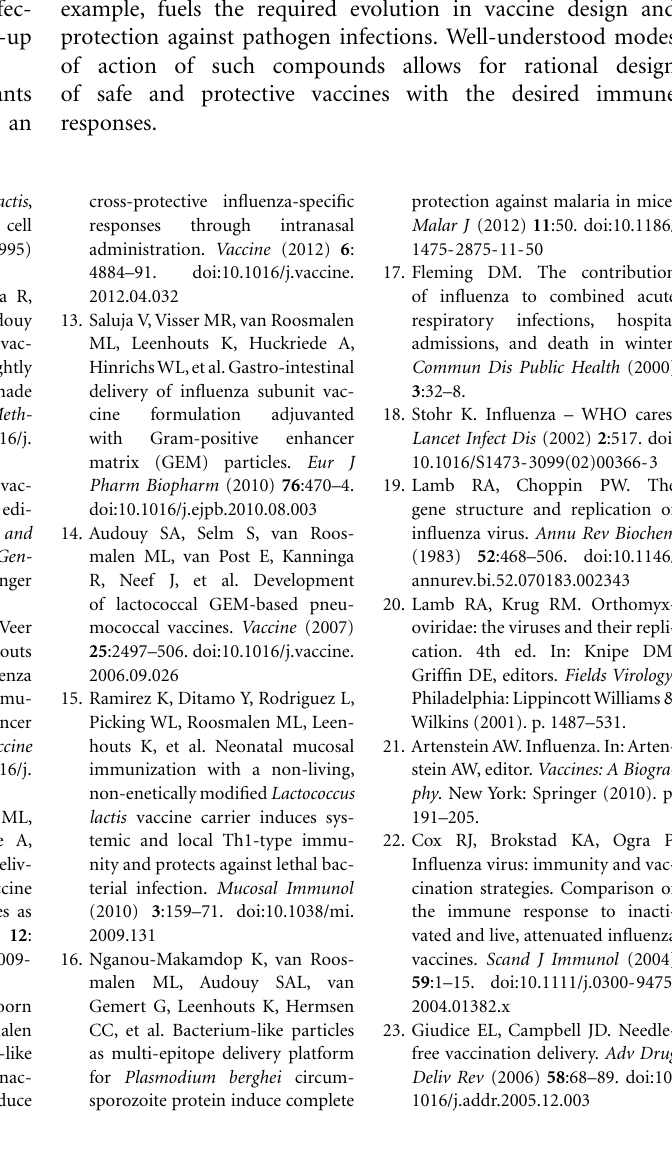
FIGURE 9 | FluGEM-A induced increase in influenza H1N1- (A) and H3N2-specific (B) IFN γ -producingT-cells. Blood samples were collected from study participants on study days 0, 7, 21, and 28. PBMCs were isolated and IFN γ -producing cells were enumerated by